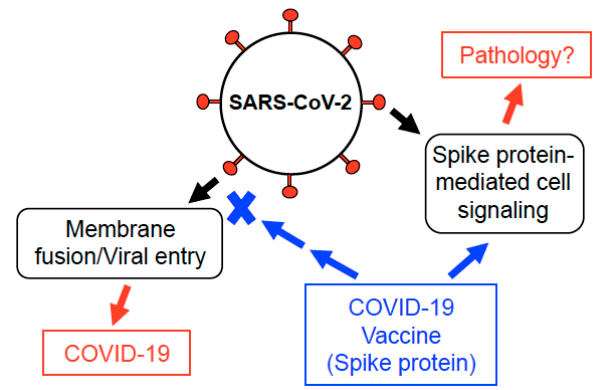
Figure 3. Possible actions of the SARS-CoV-2 spike protein. The SARS-CoV-2 spike protein of the intact virus targets ACE2 of the host cells to facilitate the membrane fusion and the viral entry. The SARS-CoV-2 spike protein also elicits cell signaling in human cells [21,29]. COVID-19 vaccines introduce the spike protein into the human body. In addition to eliciting an immune response that suppresses the viral entry, the spike protein produced by the COVID-19 vaccines may also affect the host cells, possibly triggering adverse events. Further investigations addressing this possibility are warranted.